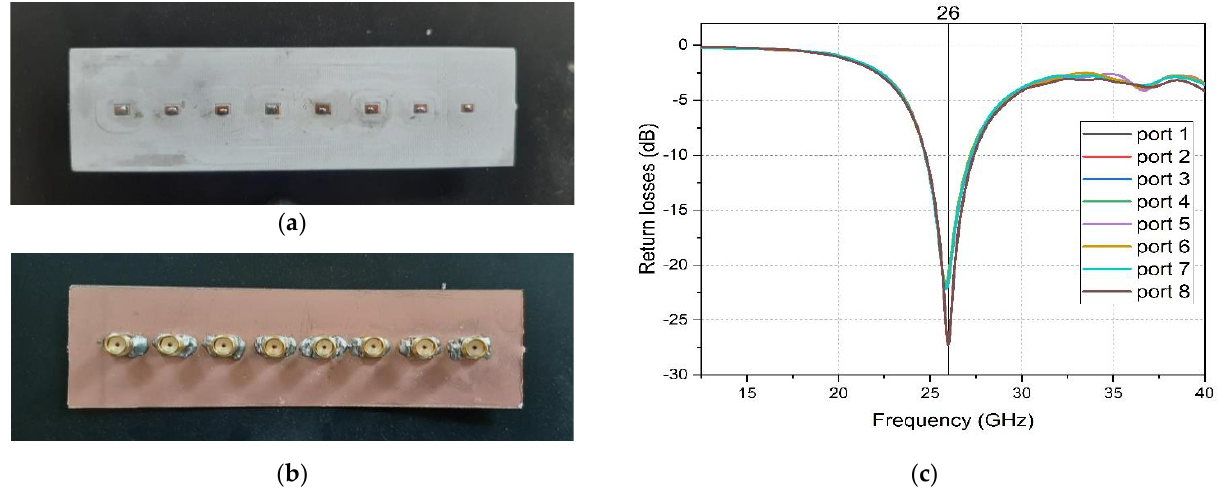
Figure 8. ( a ) Front view and ( b ) bottom view of the fabricated 1 × 8 antenna array with connectors soldered and ( c ) the return losses at the respective ports of antenna array.